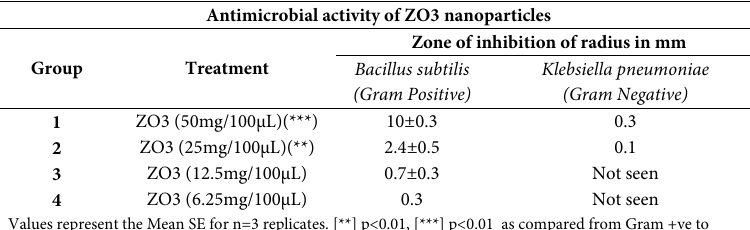
Table 7. Tabulation of the results for the zone inhibition measured in millimetre